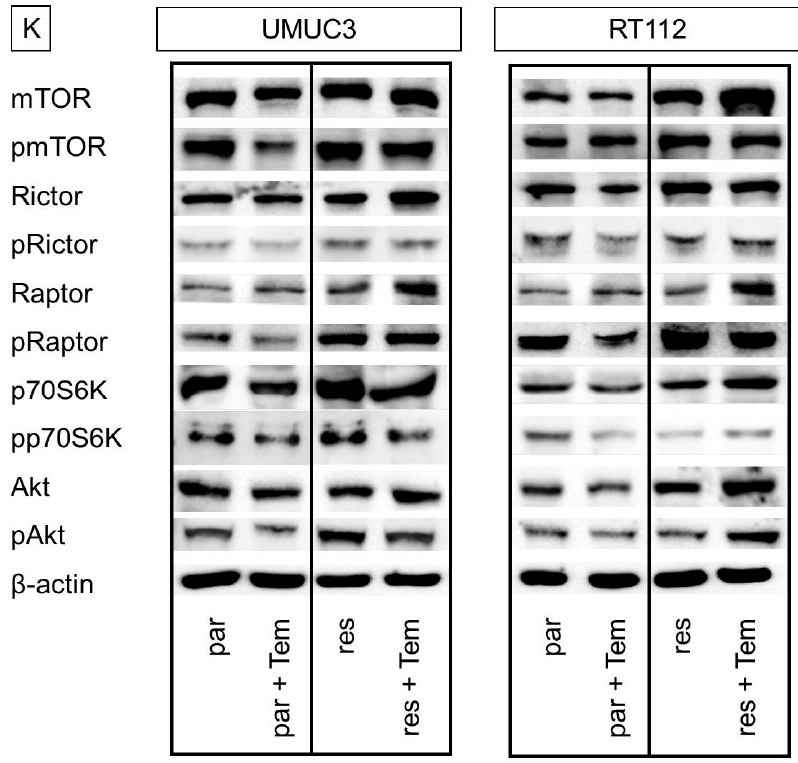
Figure 4. Protein expression profile of targeted and signalling proteins. ( A – J ) Pixel density analysis of the protein expression in parental and temsirolimus-resistant UMUC-3 and RT112 cells after 3 days of exposure to temsirolimus [10 nmol/mL]. All values are given in percentage difference to the parental control (set to 0). T = parental cells + temsirolimus, R = resistant cells, R + T = resistant cells + temsirolimus. Bars indicate standard deviation (SD). * indicates significant difference to parental control (set to 0), p ≤ 0.05. n = 4. β -actin served as internal control. ( K ) Original western blots: One representative of four separate experiments is shown. Each protein analysis was accompanied by a β - actin loading control. One representative internal control is shown here.